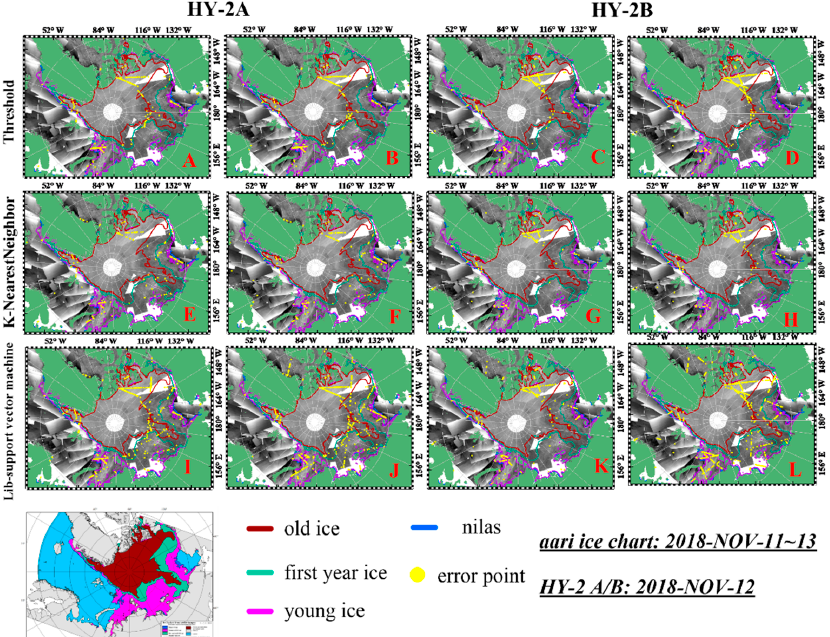
Figure 18. Distributions of the classification errors of the three methods in the Arctic regions: Figure 18A,E,I and C, G, K indicate the C Band results of the HY-2A/B, respectively; Figure 18B,F,J and D, H, L indicate the Ku Band results of the HY-2A/B, respectively. Note: The color boundaries of the different types of ice in the Figure 18A–L are consistent with the classifications in the ice chart. Remote Sens. 2019 , 11 , x FOR PEER REVIEW The AARI ice chart for 11–13 November of the Arctic region, and the ice chart for 15 November of the Antarctic region, were used in this study as references. The error points of the Arctic regions were mainly located in the old ice around Queen Elizabeth Island. The areas where the error occurs were consistent with the positions of the ‘’ocean-like’ waveforms. The error distribution of LIBSVM was the most dispersed. The errors of the KNN had occurred near the old ice and sea ice boundaries. The diffused echoes from the old ice were found to be similar to those of the seawater.